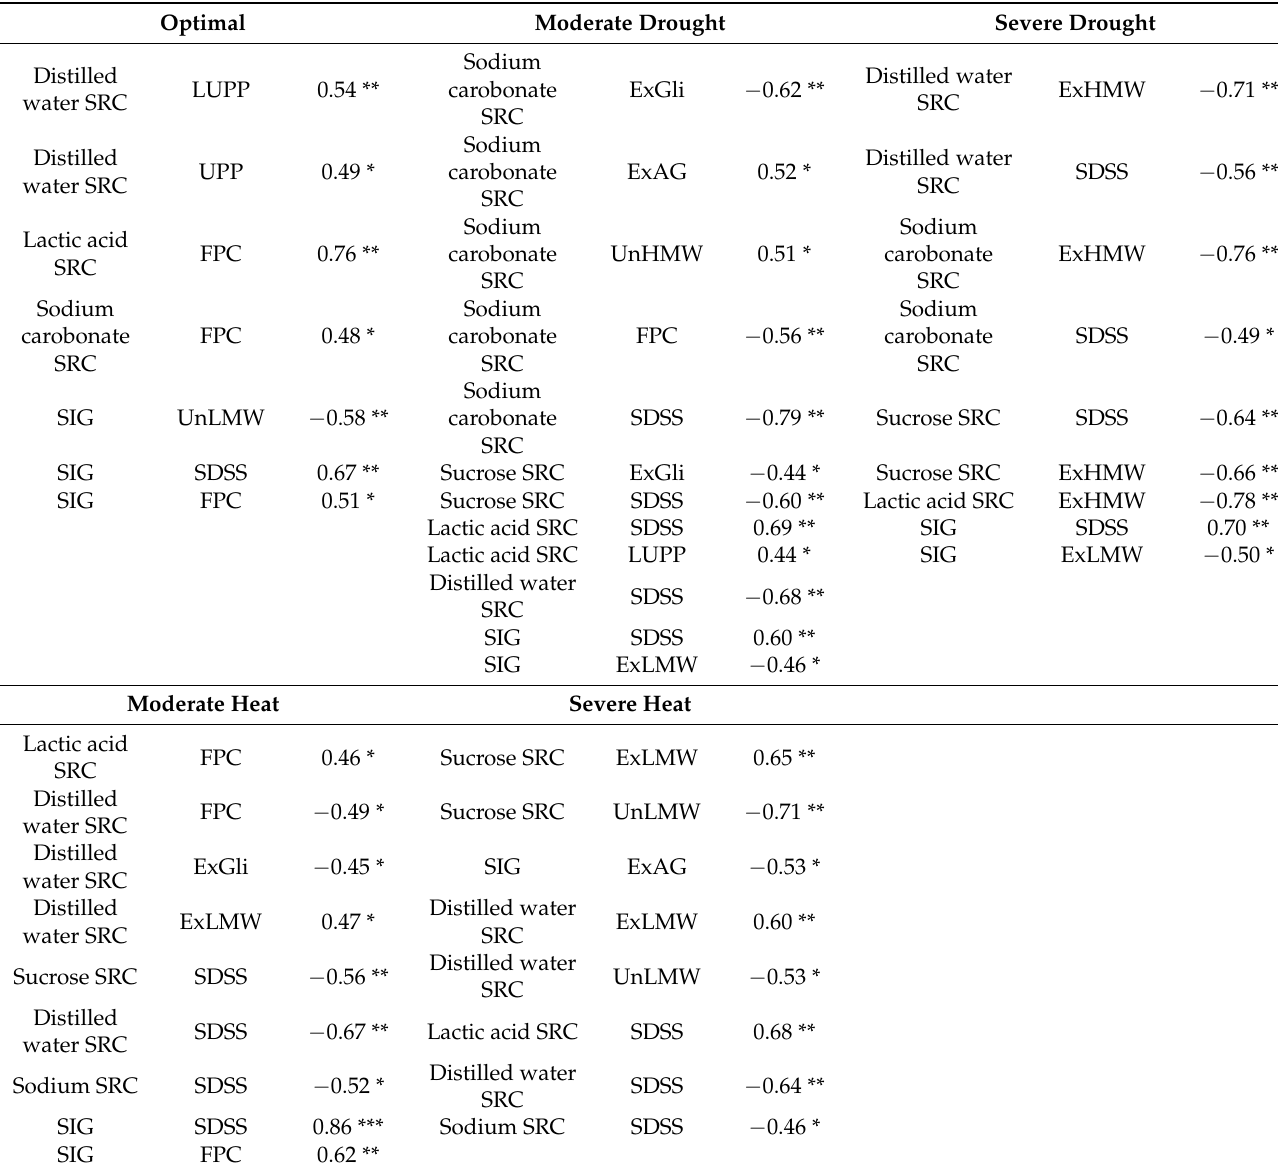
Under severe drought stress distilled water, sodium carbonate, sucrose and lactic acid SRC were all highly negatively correlated with extractable HMW. The only significant positive correlation was SIG with SDSS. Under moderate heat lactic SRC and SIG were both highly significantly correlated with FPC (positive) and distilled water SRC (negative). Under severe heat conditions, both sucrose and distilled water SRC were significantly correlated with extractable LMW (positive) and unextractable LMW (negative). SDSS was significantly correlated with lactic acid SRC (positive) and both water and sodium carbonate SRC (negative). Table 5. Significant correlations between solvent retention capacity, protein fractions, flour protein content and SDS sedimentation under different stress treatments. Optimal Moderate Drought Severe